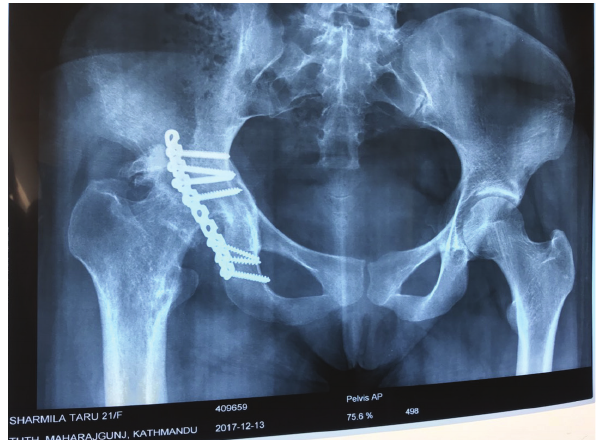
Figure 2 : Avascular necrosis with osteoarthritis on the right